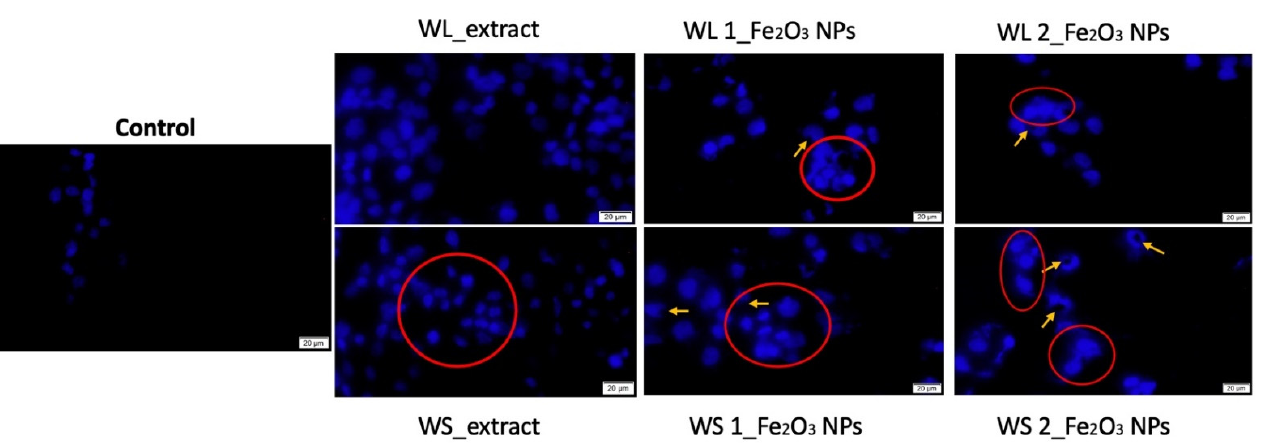
Figure 14. Morphological aspects of immortalized human keratinocytes-HaCaT nuclei treated with concentration of 500 µg/mL of both wormwood extracts: leaves (WL_extract) and stems (WS_extract) and different Fe 2 O 3 NPs obtained from these extracts (WL 1_Fe 2 O 3 NPs; WL 2_Fe 2 O 3 NPs, respectively WS 1_Fe 2 O 3 NPs; WS 2_Fe 2 O 3 NPs) for an interval of 72 h. The scale bars represent 20 µm. Fe 2 O 3 NPs that are either attached or embedded in the cells nuclei are marked with yellow arrows.